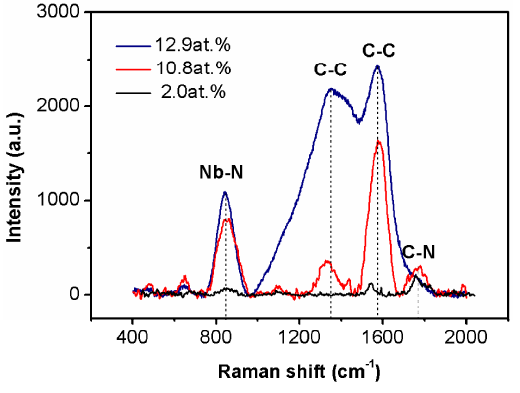
Figure 6. Raman spectrum of NbCN-Ag composite films at 2.0 at.%, 4.6 at.%, and 12.9 at.% Ag.